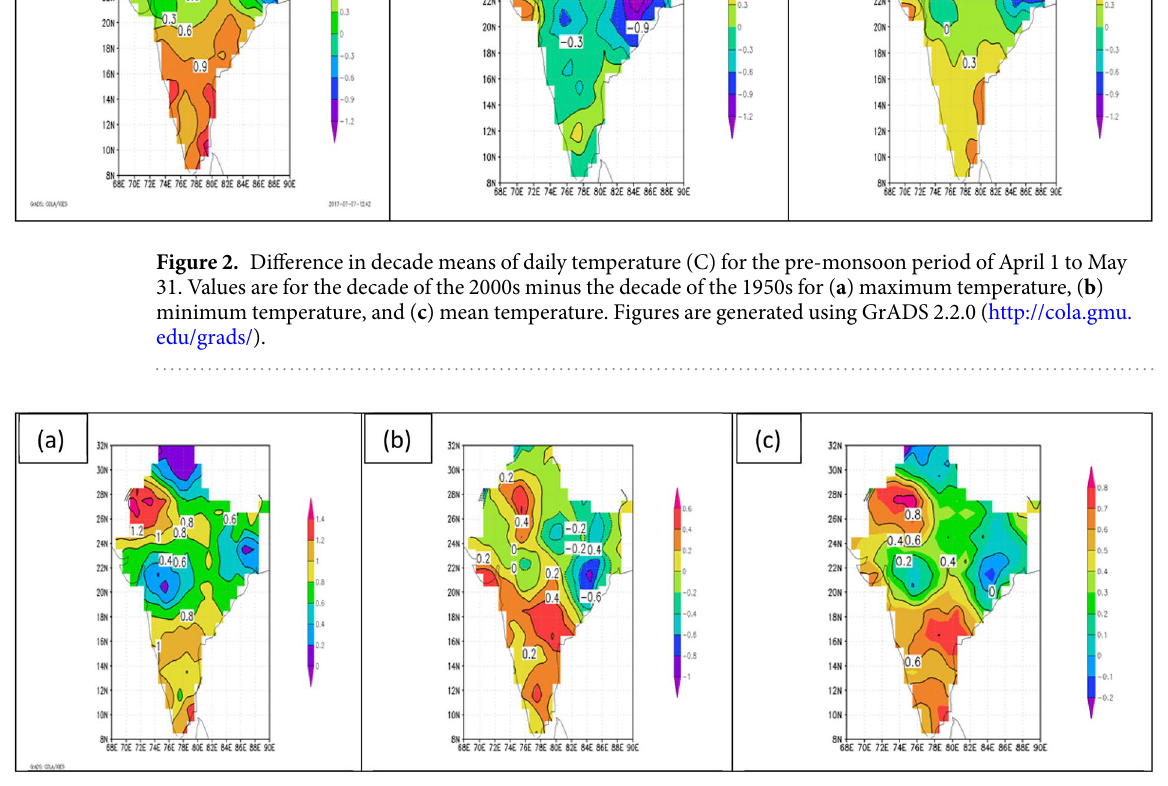
Figure 3. Difference in decade means of daily temperature (C) for the peak of the monsoon period of July 1 to September 30. Values are for the decade of the 2000s minus the decade of the 1950s for ( a ) maximum temperature, ( b ) minimum temperature, and ( c ) mean temperature. Figures are generated using GrADS 2.2.0 (http://cola.gmu.edu/grads/).